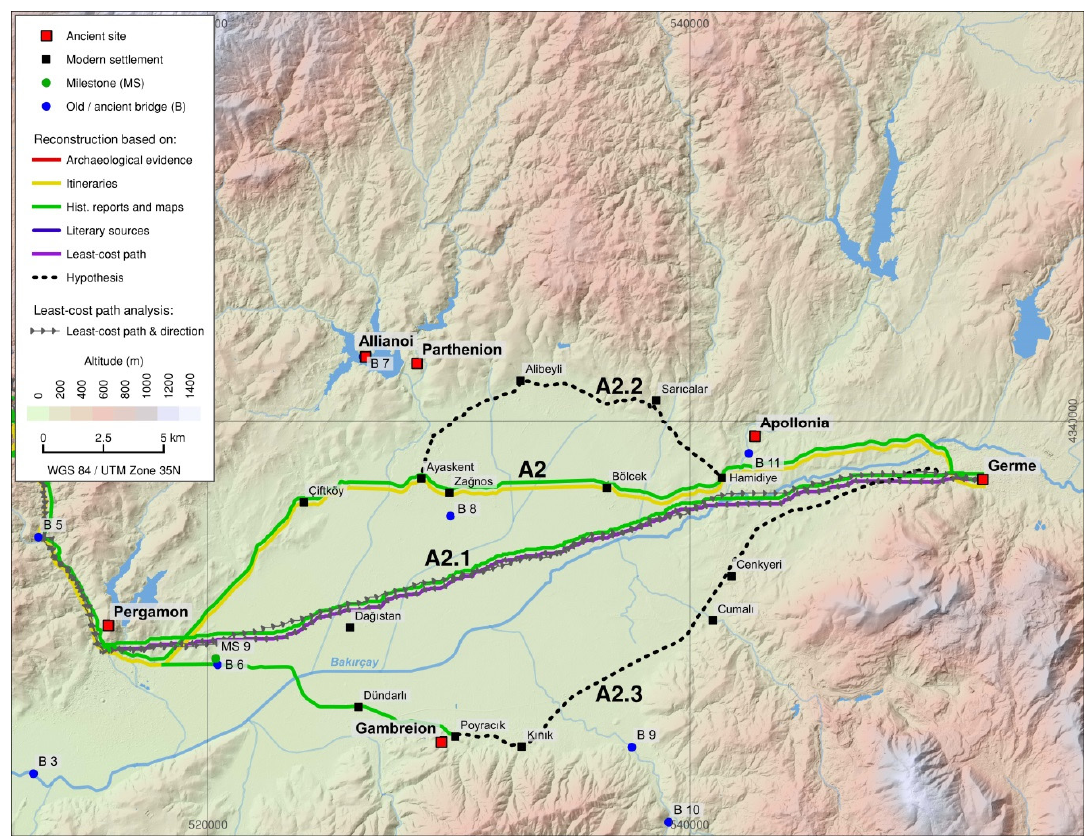
Figure 7. Calculated least-cost paths and reconstructed routes between Pergamon and Germe.